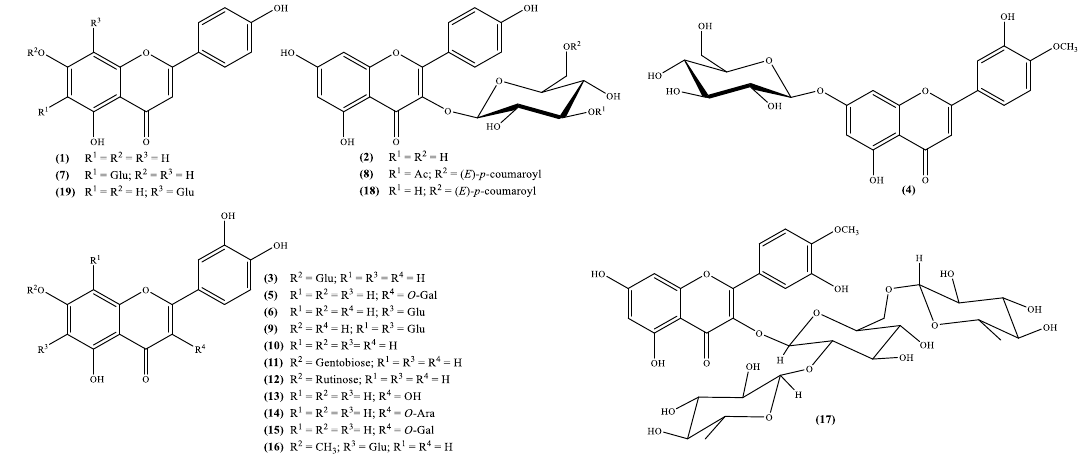
Figure 1. Flavonoids isolated from the genus Scabiosa (Ara = arabinose; Gal = galactose; Glu = glucose).